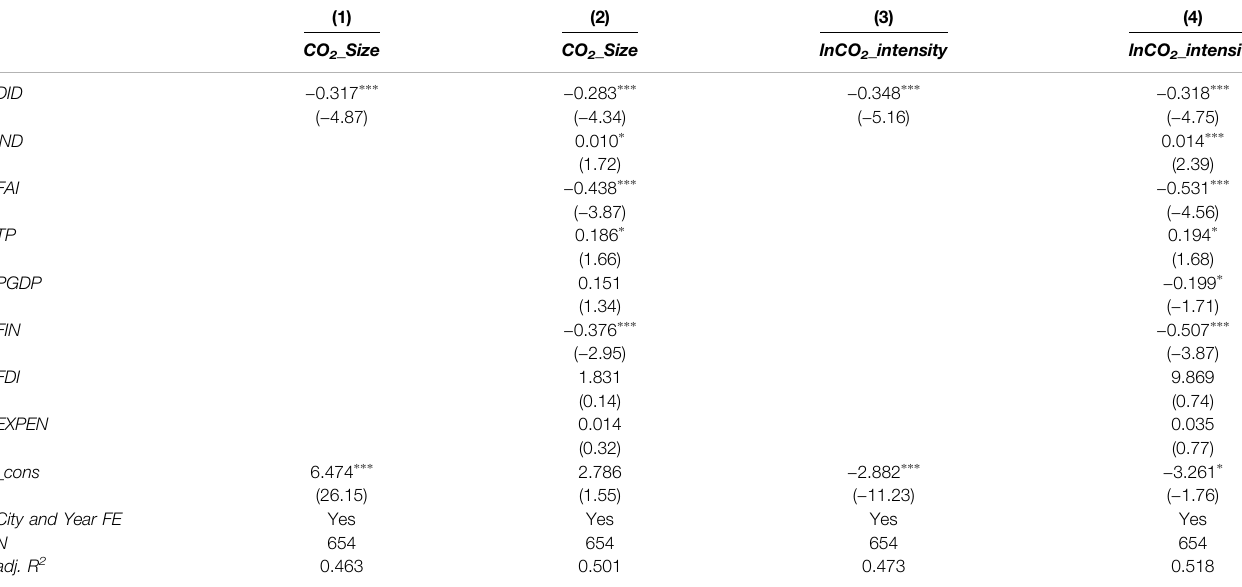
TABLE 4 | Benchmark